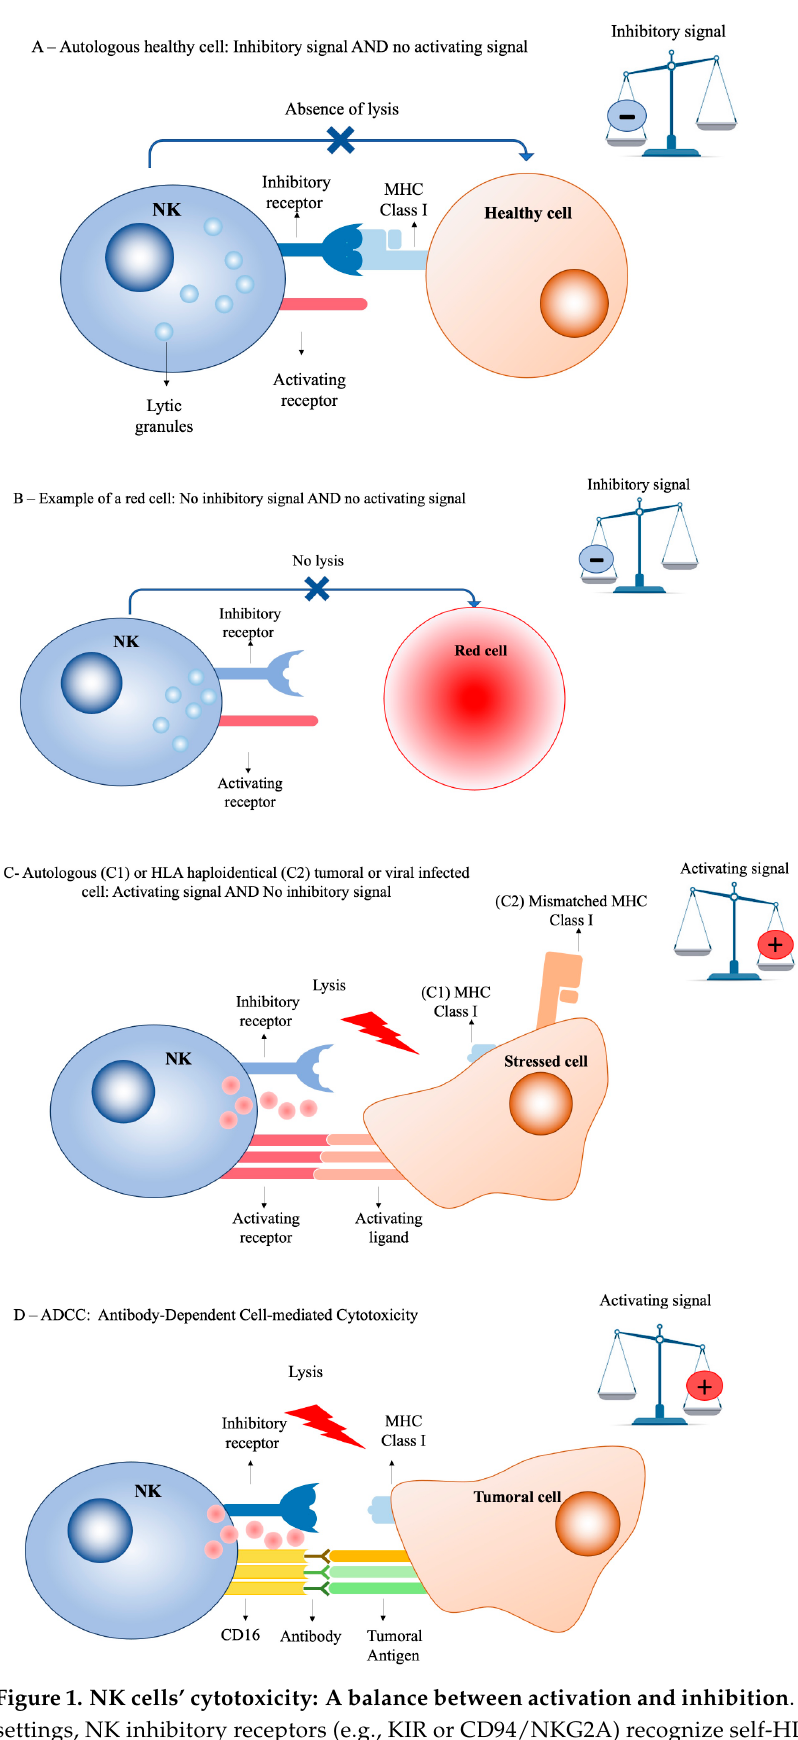
Figure 1. NK cells’ cytotoxicity: A balance between activation and inhibition . ( A ) In autologous settings, NK inhibitory receptors (e.g., KIR or CD94/NKG2A) recognize self-HLA class I